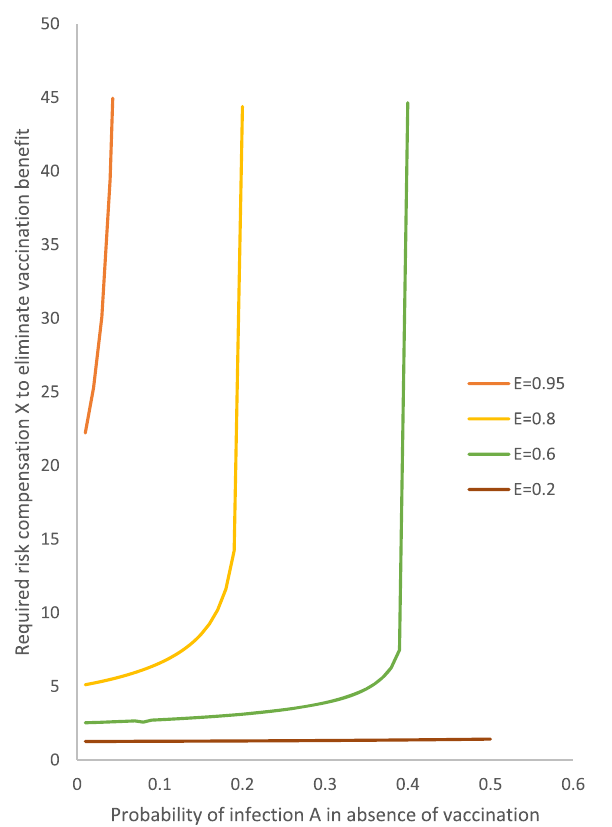
Fig. 1 Required risk compensation to eliminate the vaccination bene fi t. Scenarios presented with vaccine ef fi cacy (E) of 0.2, 0.6, 0.8, and 0.95.